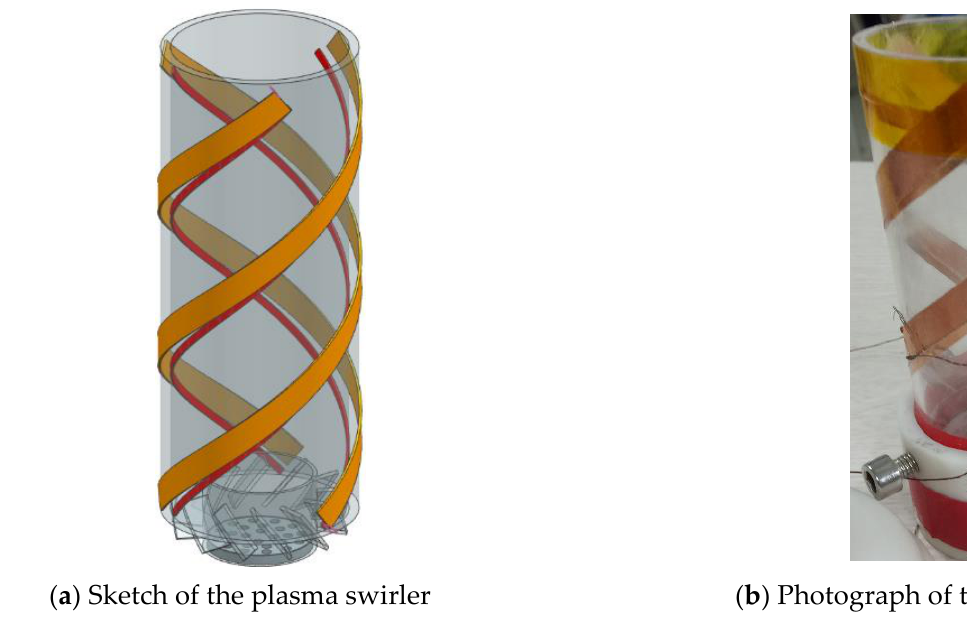
Figure 1. Sketch and photograph of plasma swirler with helical shape electrodes. In the experiment, air volumetric flow was 175 l/min and the corresponding bulk flow velocity in the injector was approximately 3 m/s. The power inputs of the plasma generator were approximately 31~76 W and the electrodes on the inner wall were activated with a peak-to-peak amplitude of 12~21 kV. Parameters of the five test cases are listed in Table 1. Table 1. The five test cases and their experimental conditions.